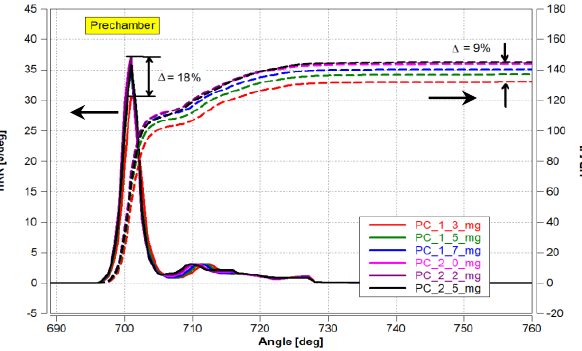
Fig. 13. Changes in HRR and HR in prechamber at different fuel dose values q o_PC